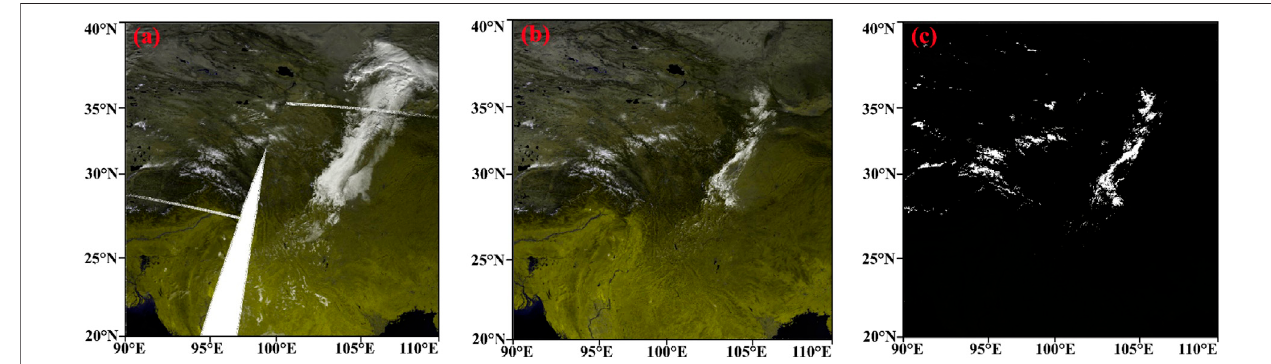
FIGURE 2 | MODIS BT Images of the eastern margin of the Qinghai-Tibetan Plateau. (A) Single-day data splicing, (B) 4-days data splicing (The white in the fi gures almostindicatesthecloud,thegreenistheregionwithoutcloudandtheblackrepresentsthewater), (C) Dataaftercloudremoval(Thewhiteregionisthecloud-removed area).